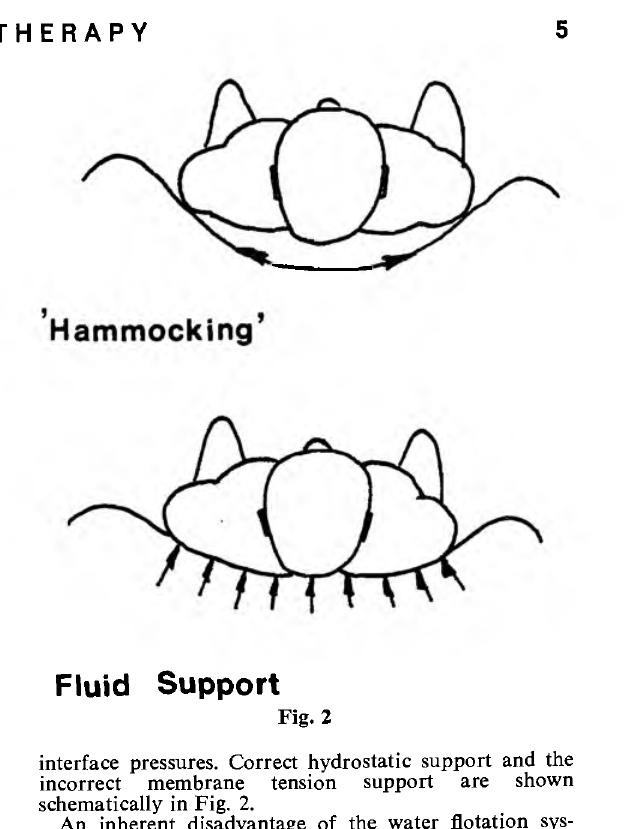
Fluid Fig. 2 interface pressures. Correct hydrostatic support and the incorrect membrane tension support are shown schematically in Fig. 2. An inherent disadvantage of the water flotation sys­ tem is the unnatural posture adopted by the patient; floating in a three-quarter submerged position with hips and knees flexed and face just above the surface. In addition, the body is only marginally stable in the water and nursing operations are difficult on the un­ stable platform offered by the water surface.